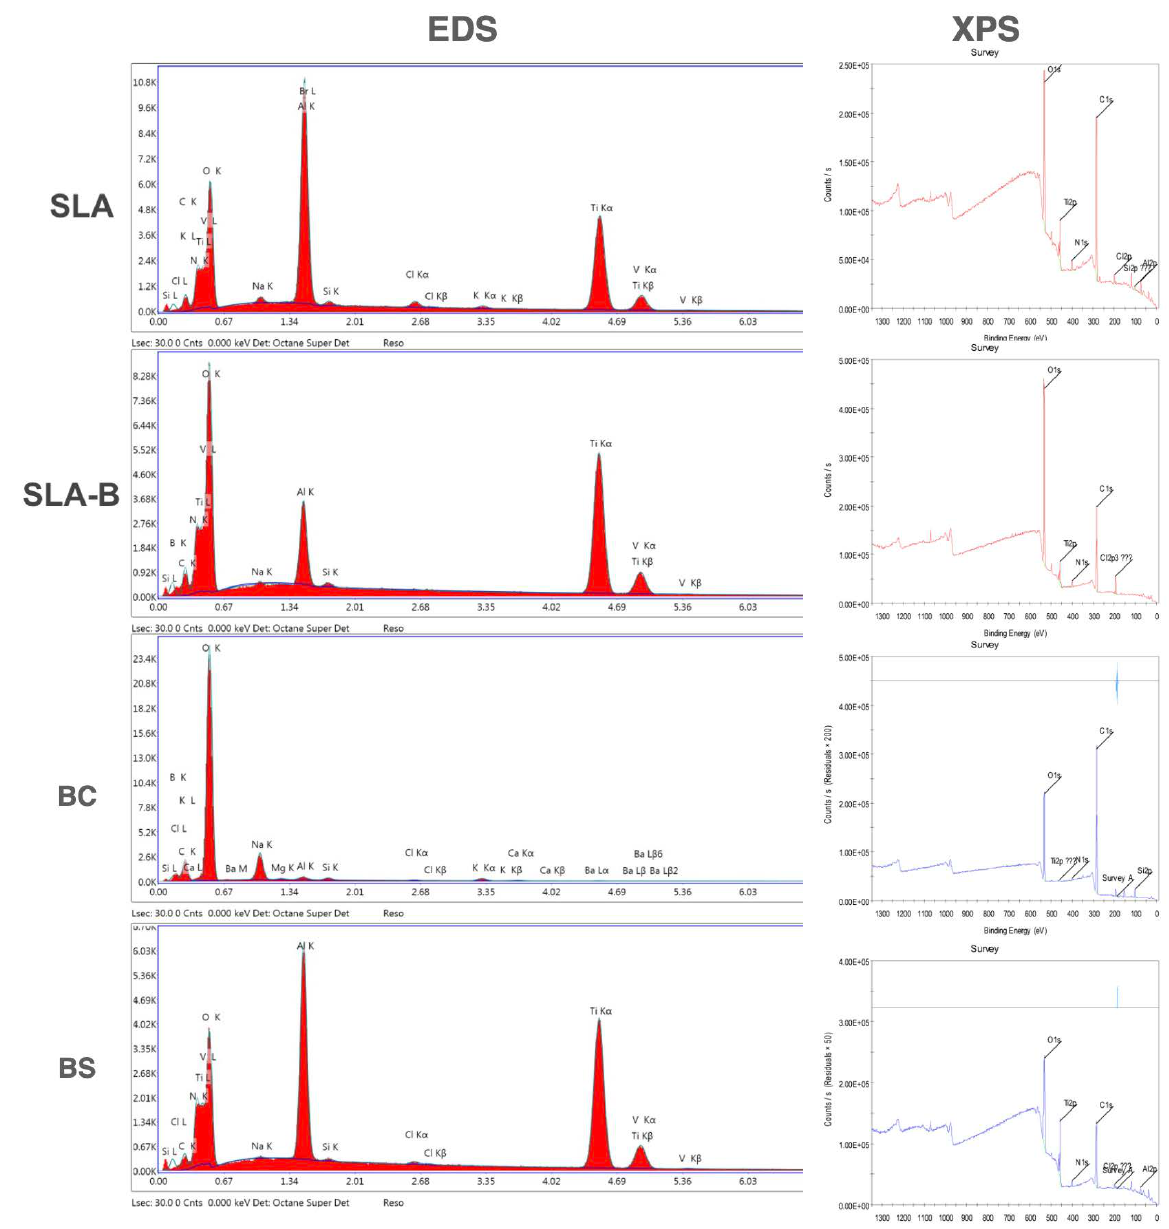
Figure 8. Energy-dispersive X-ray spectroscopy (EDS) and X-ray photoelectron spectroscopy (XPS) analysis of the SLA, SLA-B, BC and BS